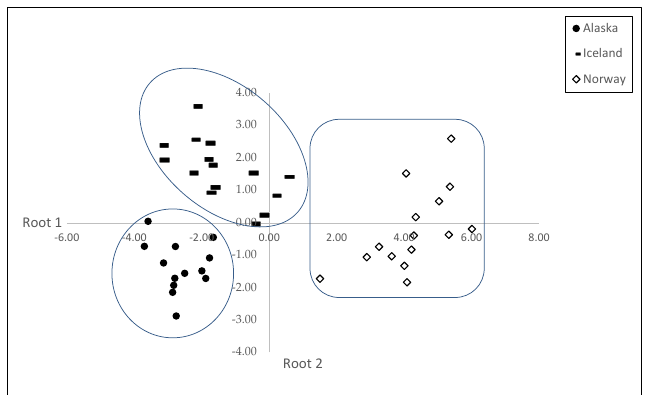
Figure 1. Plot of the discriminant functions (root 1 vs. root 2) for classification of cod varieties (Alaska, Iceland and Norway).